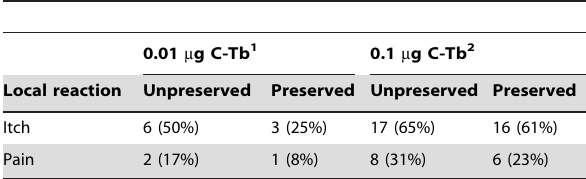
Table 3. Local adverse reactions within 28 d after injection of unpreserved and phenol preserved C-Tb.